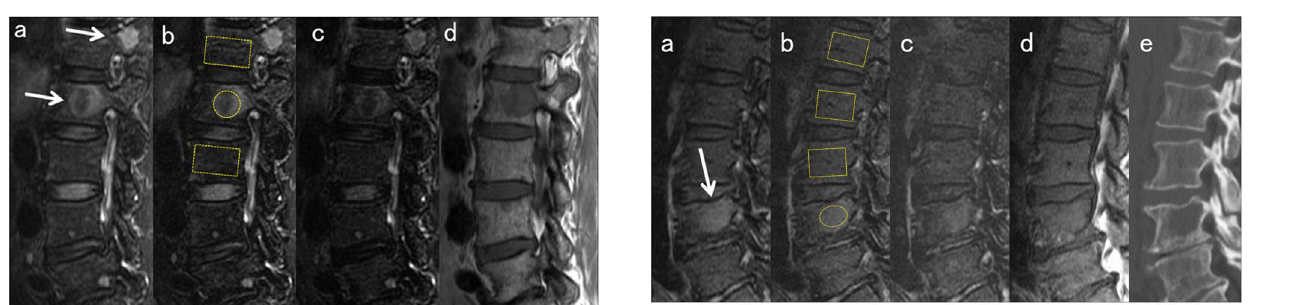
Figure 3. Sagittal MRI in a 58-year-old woman with focal myeloma lesions in the low tumor load group (BMPC%, 12%). a ) Water image of IDEAL; b ) FS- T 2 FSE; c ) STIR; and d ) T 1 FSE. ROIs of lesion and background BM used for the percent contrast computation are demarcated in the images. Actual ROIs of BM are placed in similar locations in the midsagittal images. The focal myeloma lesions in L1 and L2 are easily detected as a high intensity signal on fat-suppressed images (white arrows). Among the three fat-suppressed images, signal hyperintensity of the lesion is less conspicuous in STIR (c) than in water image of IDEAL (a), which seems to be due to the lower SNR in STIR.